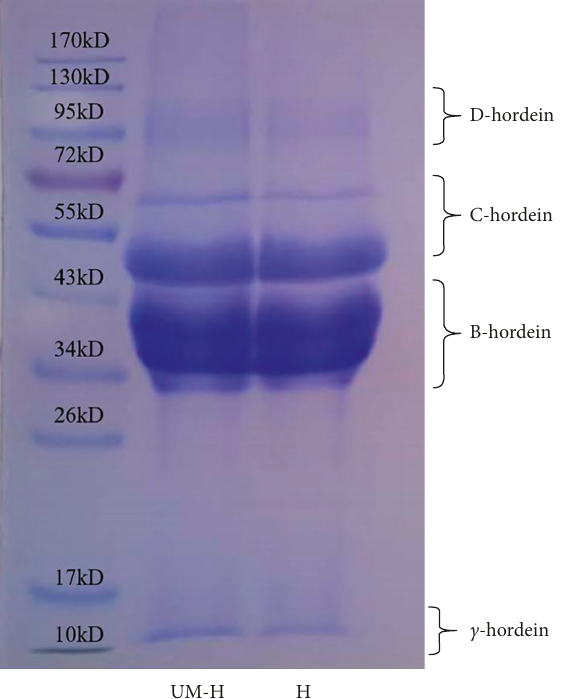
Figure 7: SDS-PAGE of hordein fractions. UM-H: ultrasonic- microwave-assisted extracted hordein; H: traditionally extracted